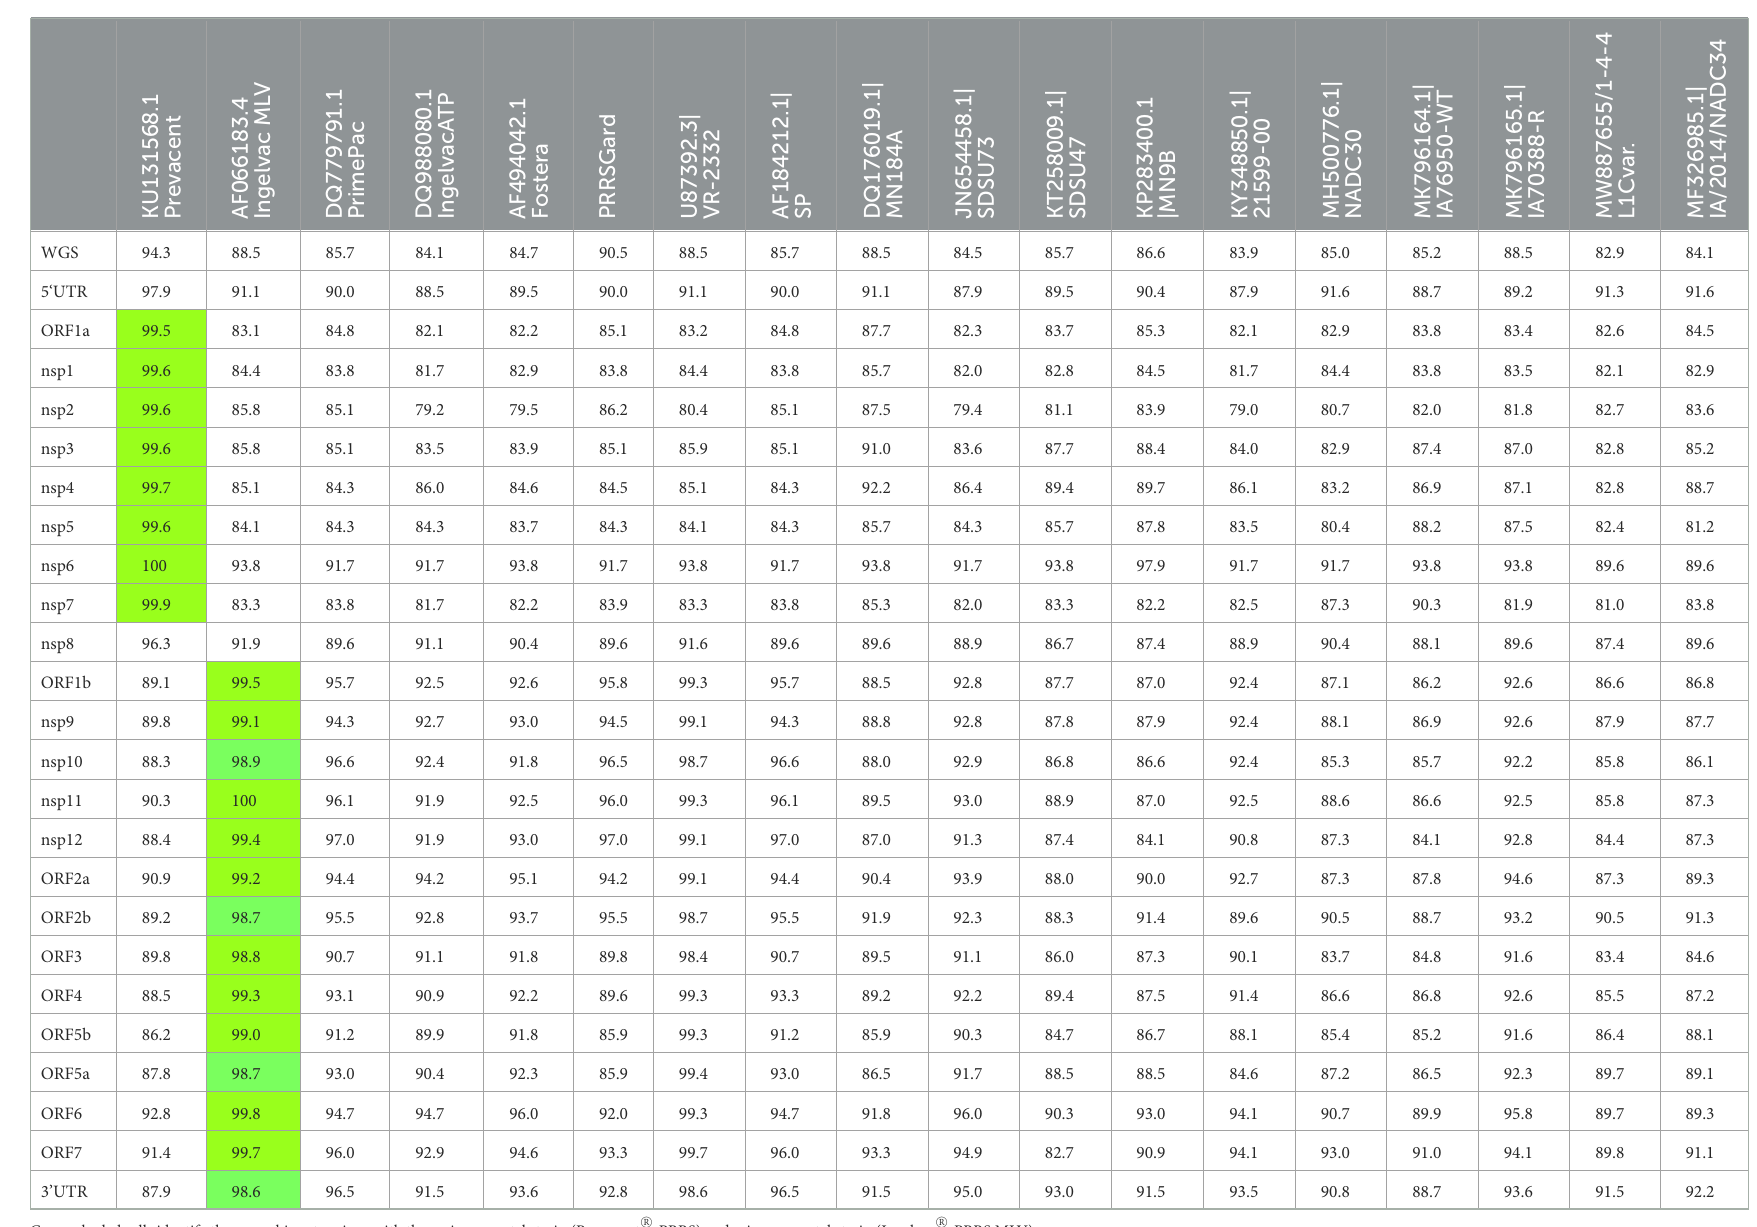
TABLE 1 Genome regions and nucleotide identity between isolate USA/IN105404/2021 and other vaccine and wild-type